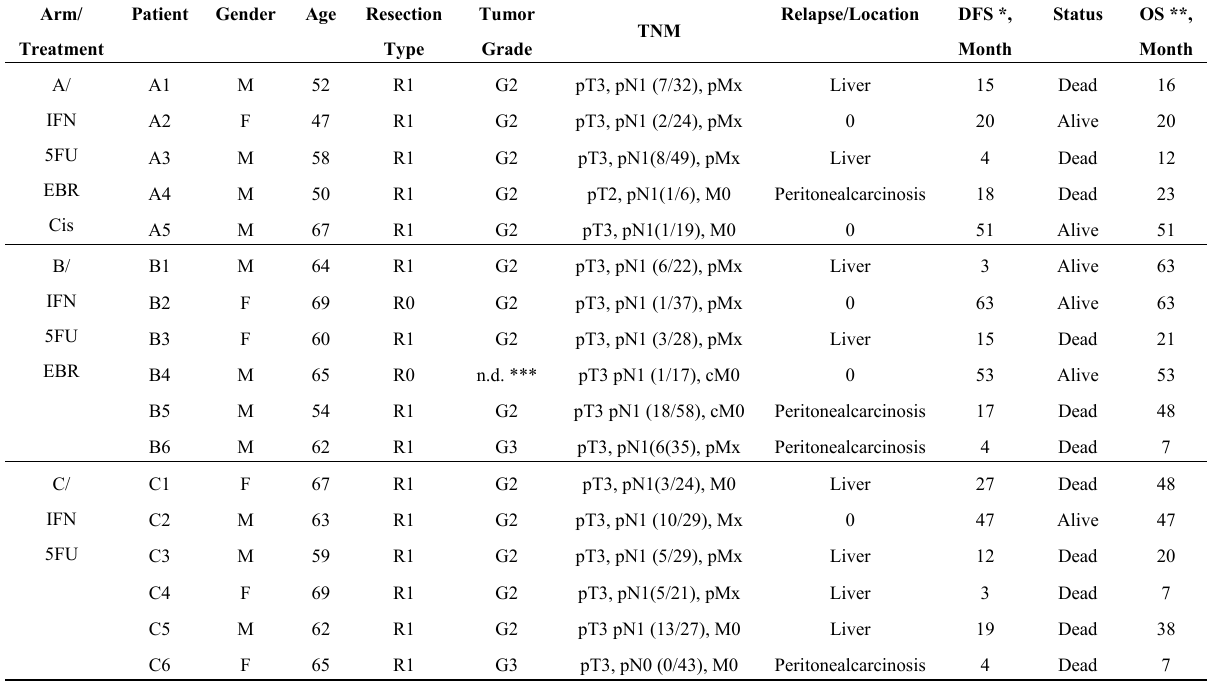
Table 1. Patients’